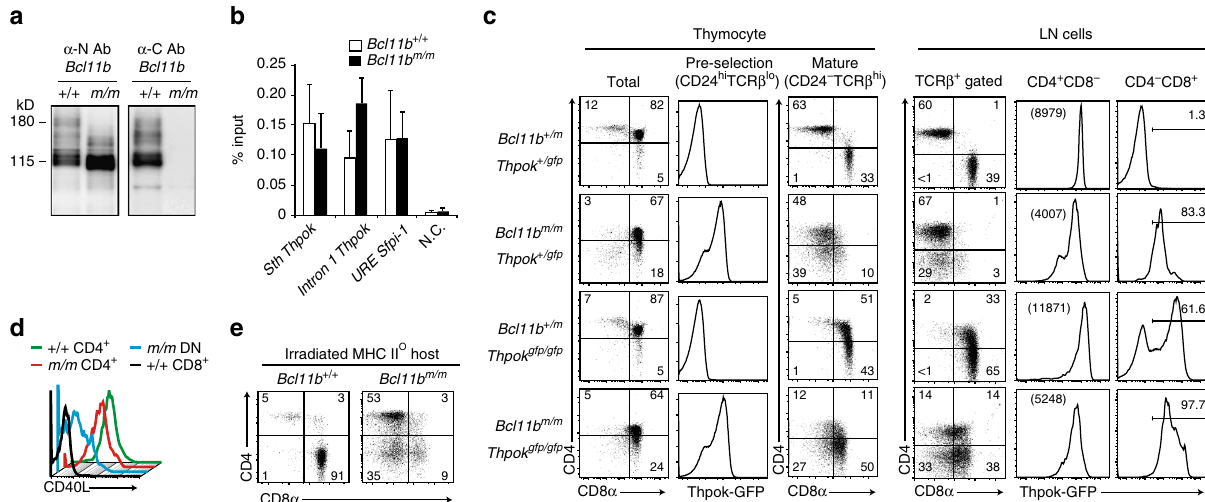
Fig. 2 CD4-skewed development by impaired Thpok regulation from hypomorphic Bcl11b m/m progenitors. a Expression of truncated Bcl11b protein in the neonatal thymus from the hypomorphic Bcl11b m allele detected by an antibody recognizing the N- ( left ), but not the C- ( right ), terminus of Bcl11b. One representative of two experiments. b Summary of ChIP assay for binding of Wt (white bars) and hypomorphic (black bars) Bcl11b to indicated regions in total neonatal thymocytes. c − e Flow cytometry analyzing the expression of CD4, CD8, and Thpok-GFP during T cell development in Rag1-de fi cient hosts c and irradiated MHC-II de fi cient hosts e reconstituted with fetal liver cells with the indicated genotypes. Data are representative of at least two independent experiments. Numbers in dot plots indicate the percentage of cells in each quadrant. Histograms showing CD40L expression 2 days after in vitro TCR stimulation of peripheral CD4 + , CD8 + and CD4 − CD8 − DN cells differentiated in Rag1-de fi cient mice from Bcl11b + / + and Bcl11b m/m fetal liver cells d . Data